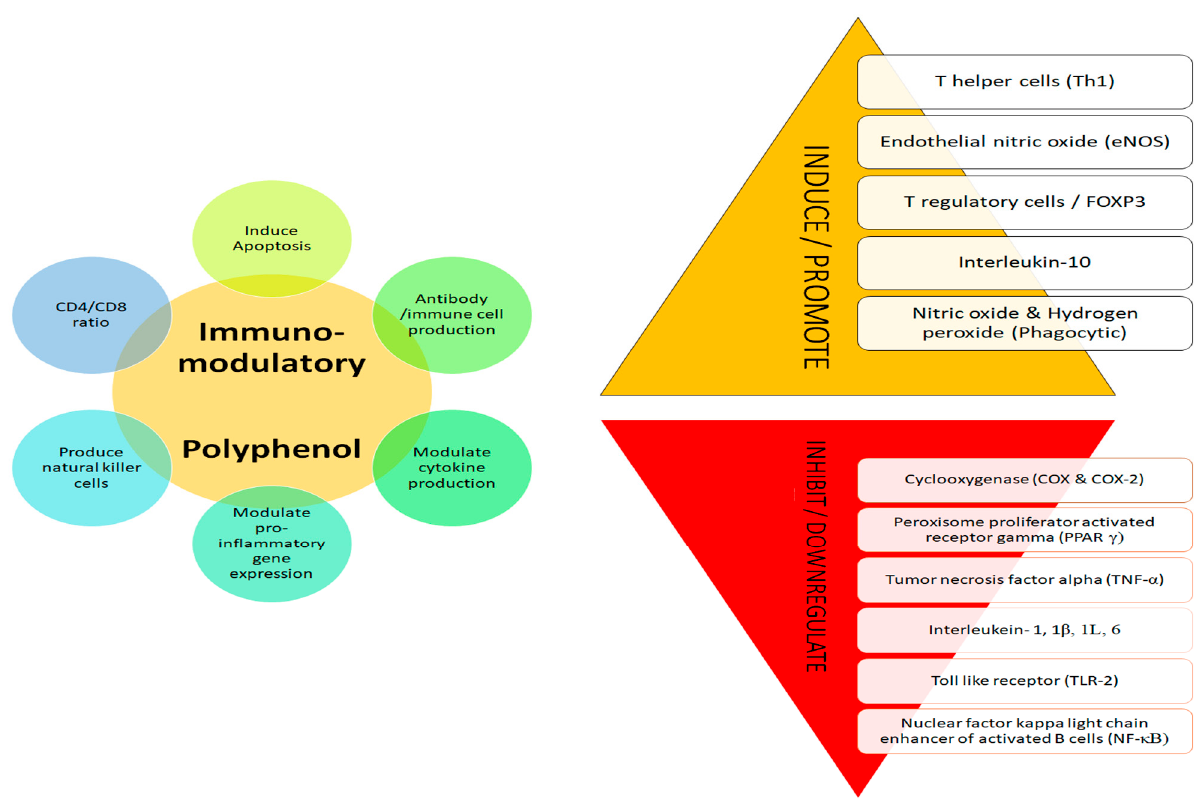
Figure 3. Immunomodulatory mechanism of polyphenol.